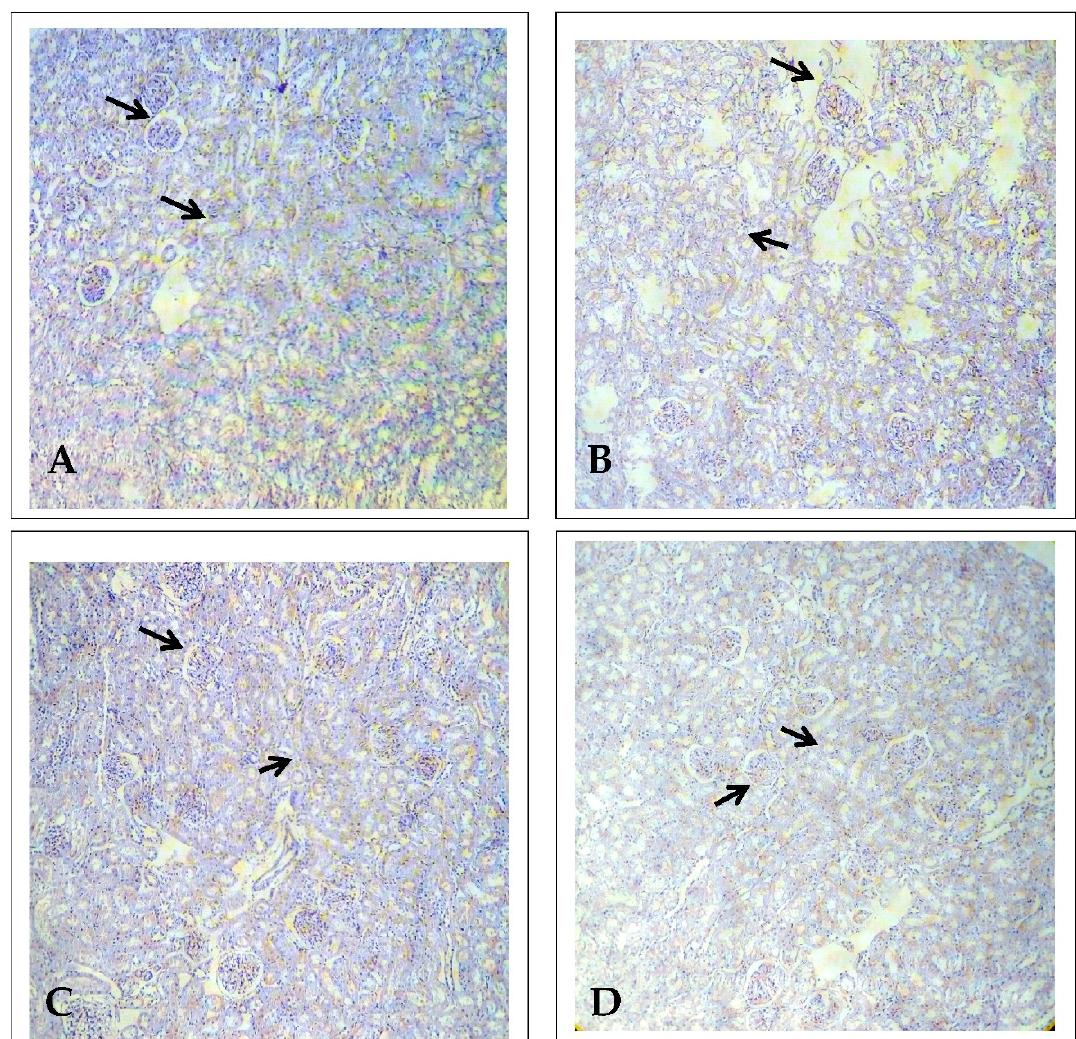
Figure 1. Histopathology of the kidney examined using periodic acid–Schiff (PAS) staining ( n = 6) (100× magnification). ( A ) Control animals, with well-defined glomeruli with Bowman‘s capsule, and renal tubules. ( B ) Lead acetate (PbA, 30 mg/kg body weight (b.w.)) treated kidney shows shrunken glomeruli with dilated Bowman‘s capsule and degenerated renal tubules. ( C ) N -acetylcysteine (NAC; 200 mg/kg b.w.) + PbA (30 mg/kg b.w.) treated kidney shows renal glomeruli and cortical tubules. ( D ) Ethanolic extract of Celastrus paniculatus seeds (EECP; 800 mg/kg b.w.) + PbA (30 mg/kg b.w.) treated kidney show normal glomeruli having well-structured Bowman’s capsule, as well as distal and proximal convoluted tubules.